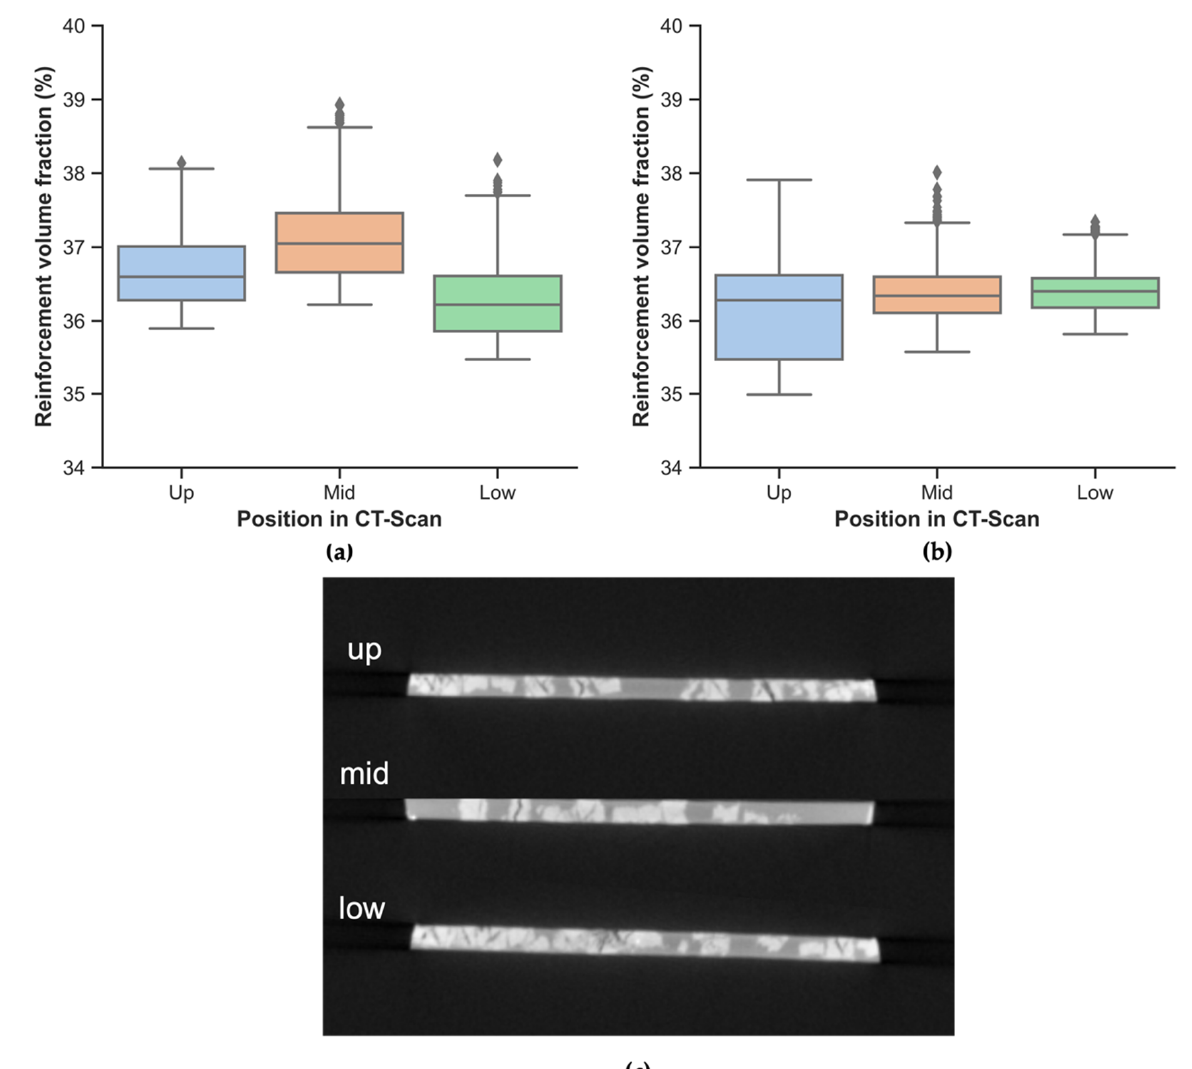
Figure 4. Reinforcement volume fraction (V r ) obtained by µ CT. ( a ) PA11 composites; ( b ) PA12 composites. ( c ) µ CT image from PA11 composites’ cross-section before applying thresholding. The line in the middle of the box in ( a , b ) corresponds to the median; the upper and lower limits of the box correspond to the 75th and the 25th percentile, respectively. Whiskers extend beyond the limits of the box to a maximum of 1.5 times the interquartile range (IQR), the difference between the 75th and the 25th percentile. Outliers are shown as individual points beyond the whiskers. In ( c ), the background is black, the matrix is grey, and the reinforcement is whitish.